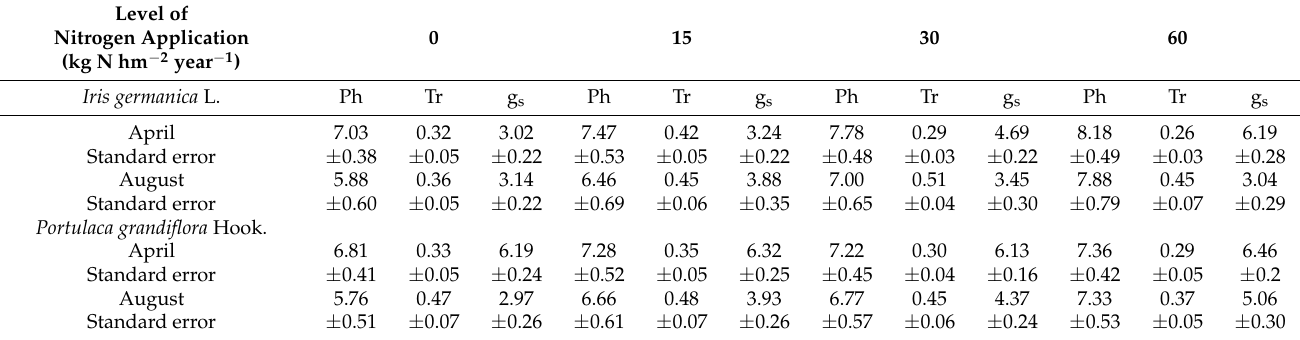
Table 1. The absolute values of plant measurements in spring and summer: photosynthetic rate (Ph), transpiration rate (Tr), stomatal conductance (g s ), and corresponding standard errors. Level of Nitrogen